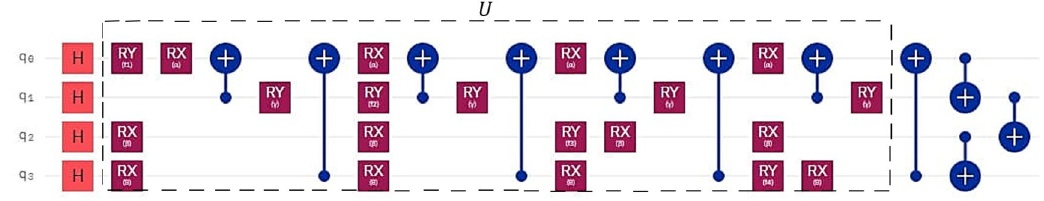
Figure 7. A quantum circuit with a quantum transfer learning method 28